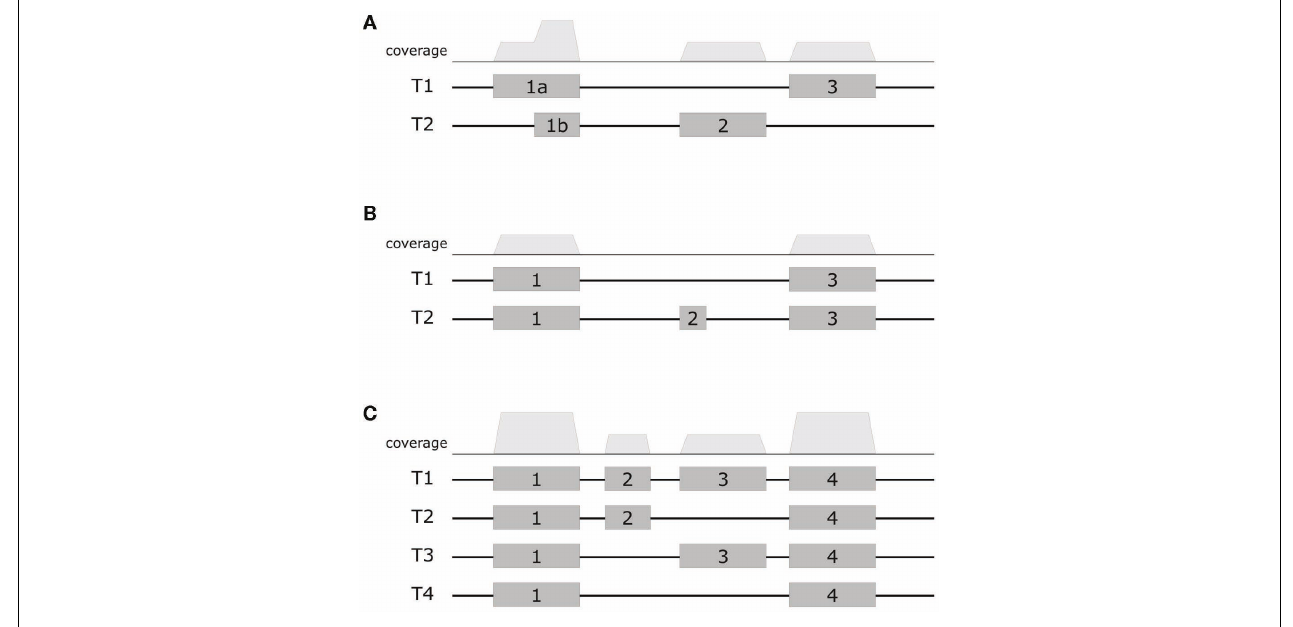
read alignments that fall on splice junctions can already considerably affect presence calls and estimates of specific splice-form expression levels. In the most complex model, adding read alignments that fall on splice junctions plays a critical role in assessing the specific splice-form expression levels. In this scenario additional evidence will boost the expression level estimate for the dominant splice-form, while depressing the expression level estimates for the others.